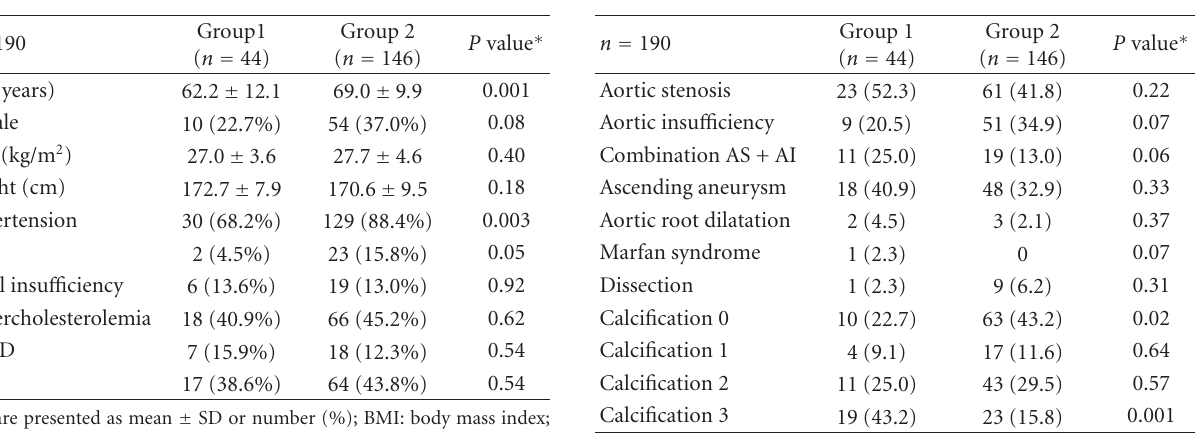
Table 1: Demographics. Table 2: Underlying pathology.